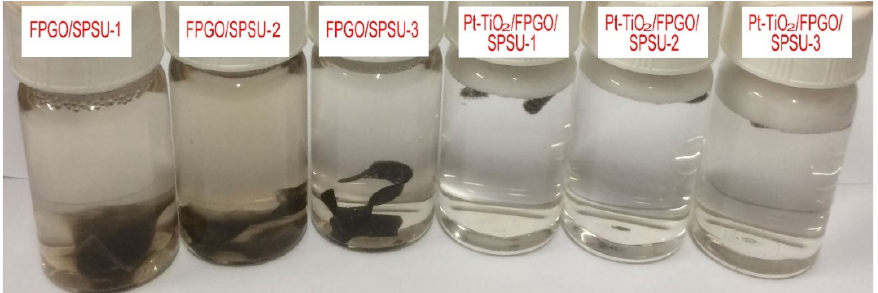
Figure 5. TGA curves of all the membranes.